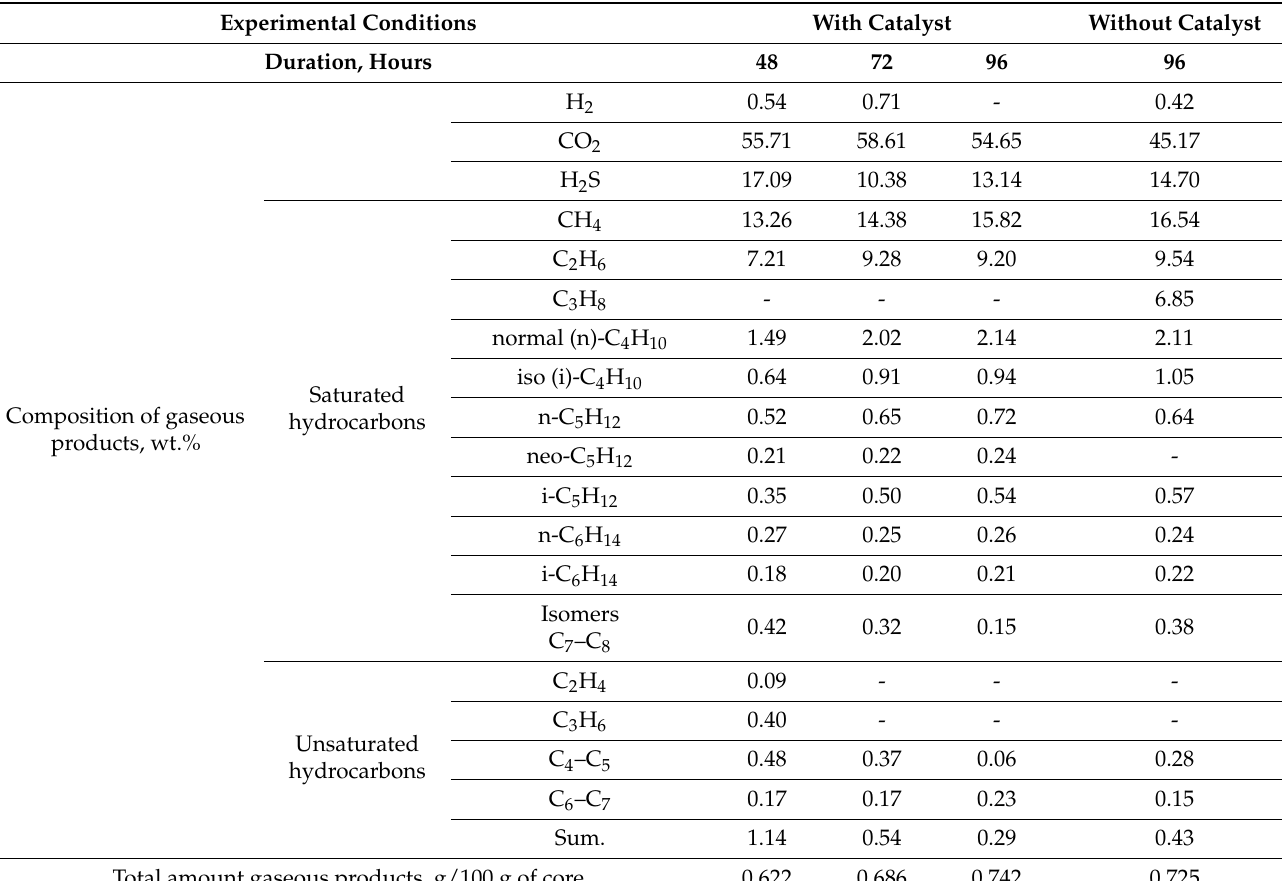
Total amount gaseous products, g/100 g of